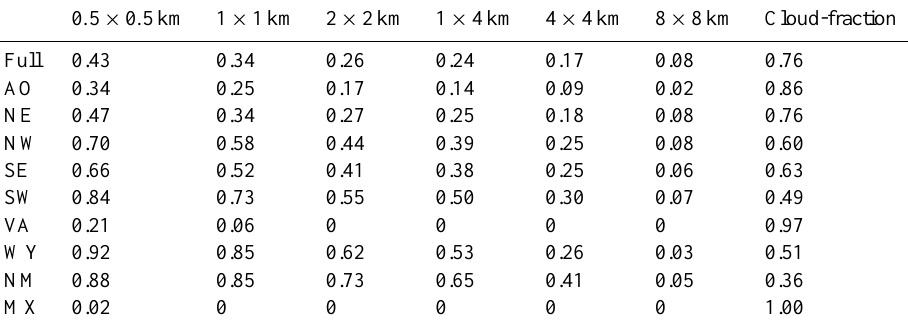
Table 5. Calculated availabilities using MODIS aerosol cloud mask for 12 August 2010 for six spatial resolutions and ten domains including the four local areas shown in Fig. 8. Also shown are cloud fractions based on 0 . 5 × 0 . 5km resolution cloud mask for each domain for this